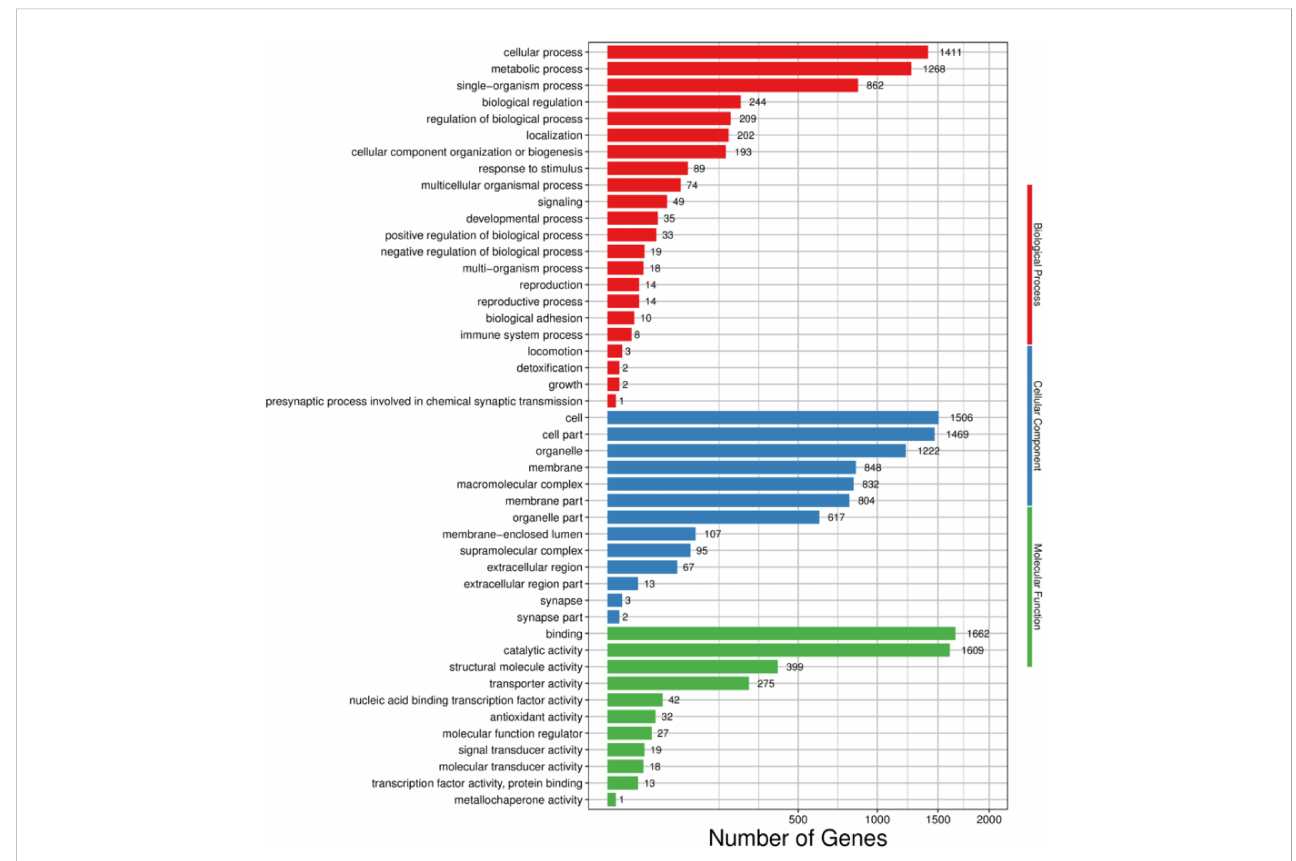
FIGURE 2 GO functional classifcations of H. cunea transcripts. Red, blue and green represent biological process, cellular component and molecular function, respectively. The x-axis represents the number of transcripts; the y-axis represents GO